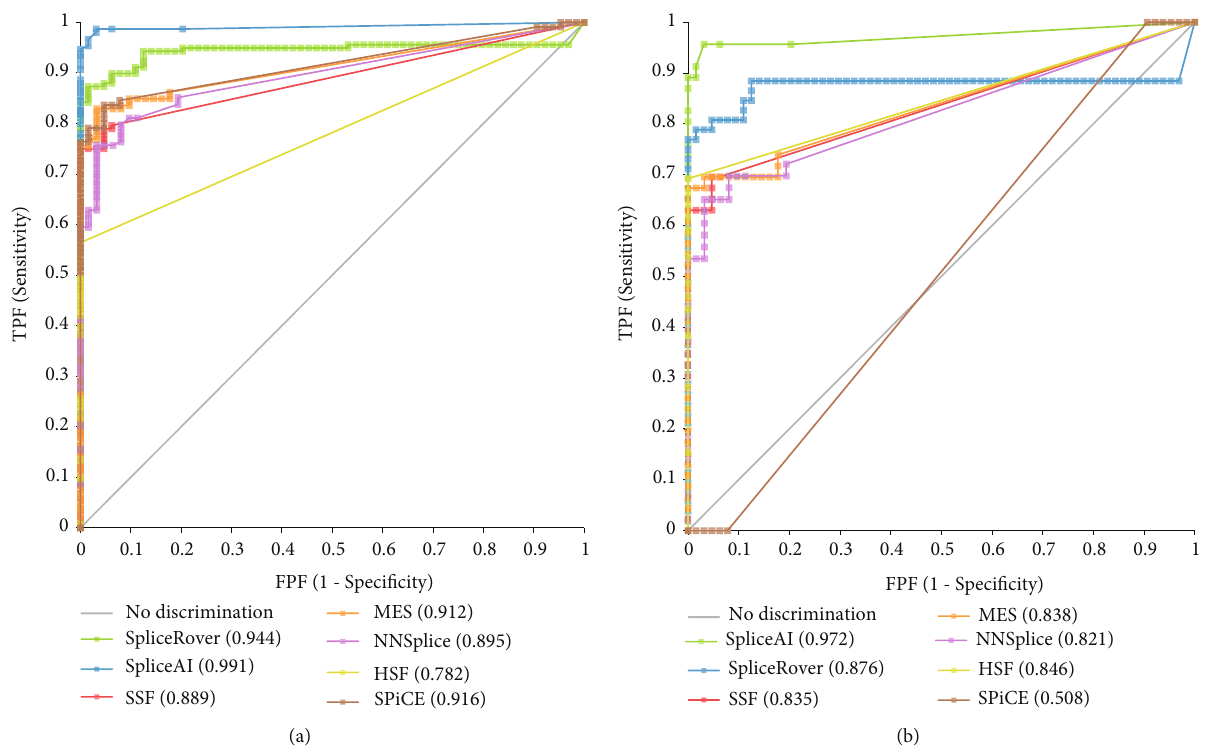
Figure 1: ROC curves with AUCs of the seven in silico tools implemented in the study (a) for all splice sites and (b) only for de novo or cryptic splice